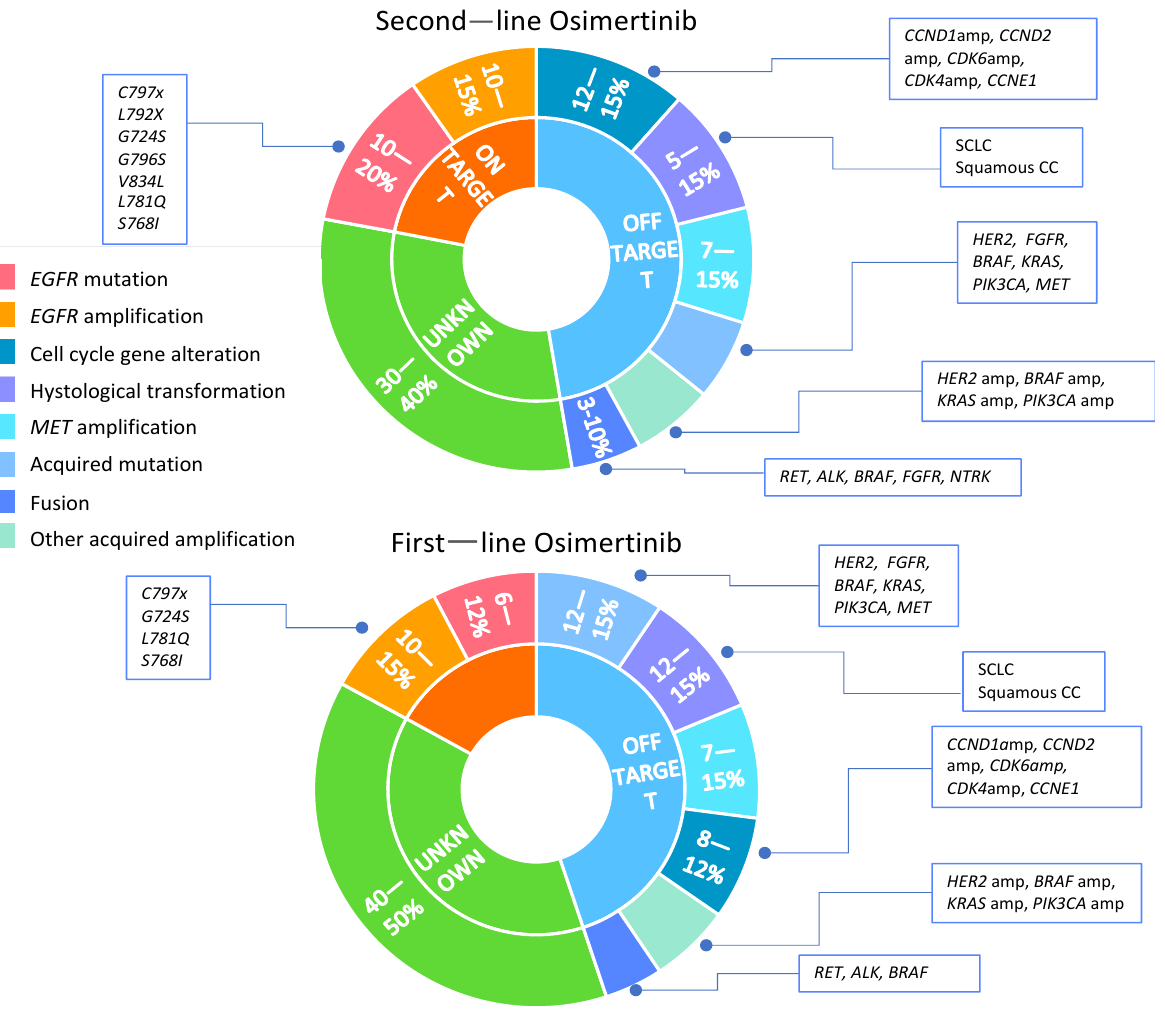
Figure 1. Acquired resistance mechanism to osimertinib in first- and second-line treatment. Amp — amplification; SCLC — small cell lung cancer; squamous CC — squamous cell carcinoma.